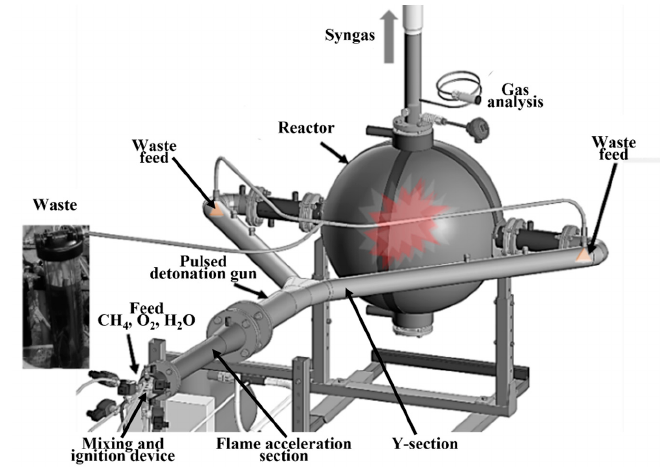
Figure 2. Schematic of organic-waste gasifier with a pulsed detonation gun.